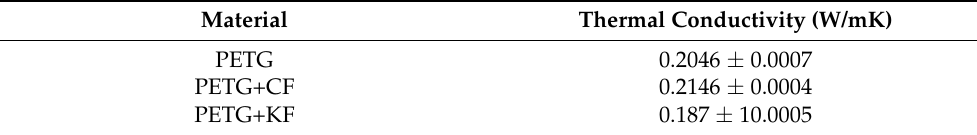
Table 13. Results of the thermal analysis for PETG, PETG+CF and PETG+KF.